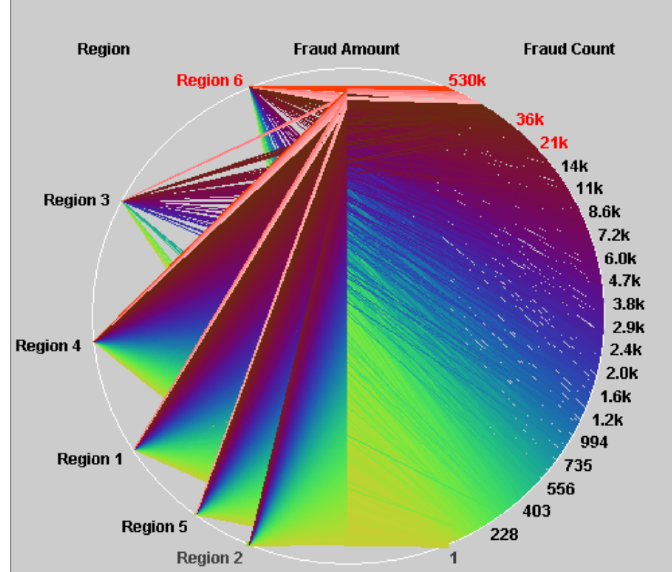
Figure 12. The BizViz visualisation. The left side of the circle shows each geographical region the data was collected from. Lines are drawn from each region to the centre line which holds a range denoting fraud value. From there, the line crosses over to the right axis where the fraud count is tallied. The user can select a region to drill down into and reveal comparisons of the fraud value vs. fraud count. Image courtesy of Hao et al.